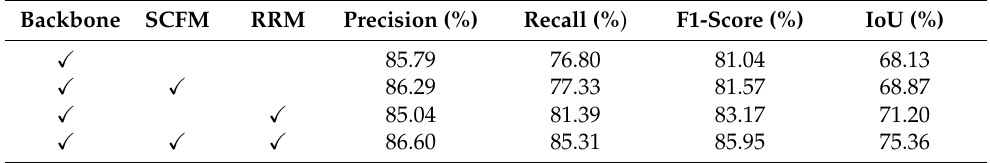
Table 3. Quantitative evaluation of the combination of different modules on the Wenzhou data set. Backbone SCFM